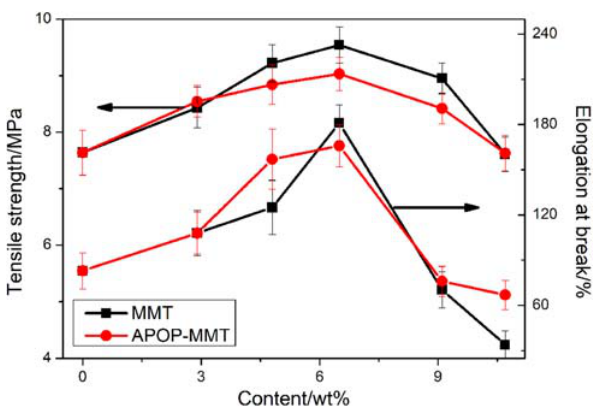
Figure 13: Mechanical properties of the MMT/PEBAX® 1074